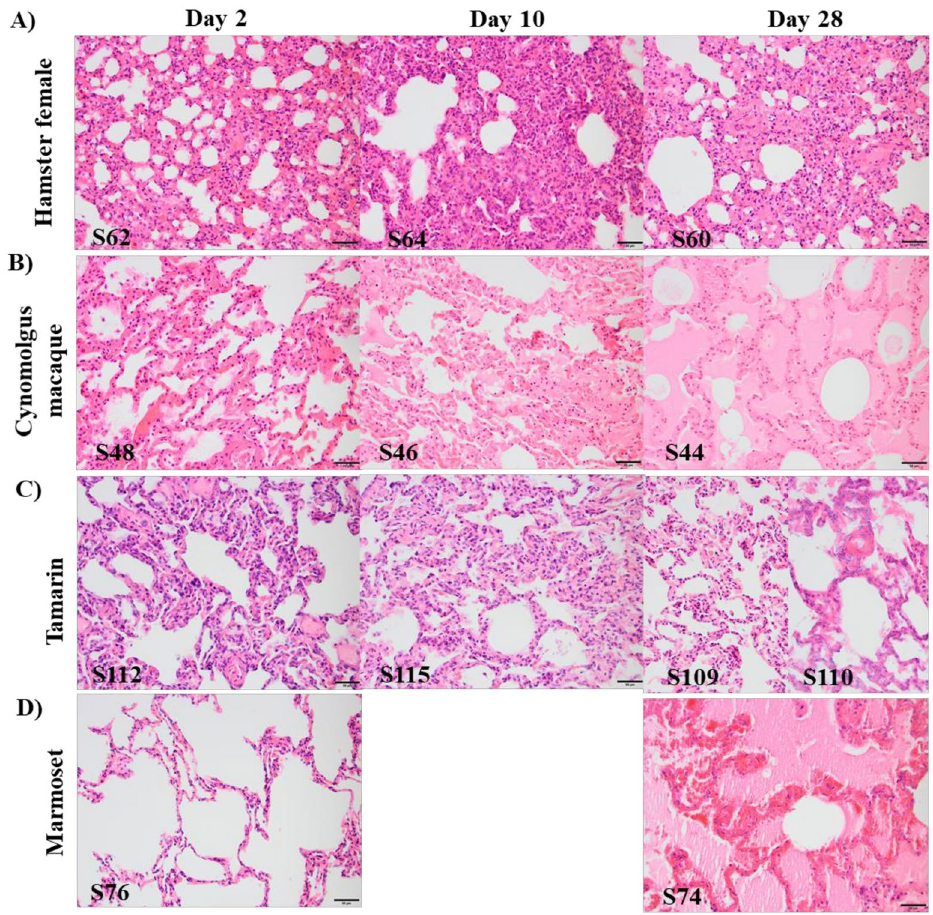
Figure 5. Comparative histopathological outcomes in lung section across the time-course of four species. Haematoxylin and eosin (H&E) staining of representative sections of lung tissue for: ( A ) female hamster lungs showing multifocally extensive alveolar wall congestion and mild to moderate protein-rich alveolar oedema. Foci of interstitial pneumonia with type II pneumocyte hyperplasia, and infiltrates of mixed inflammatory cells, including neutrophils, and single cell necrosis. ( B ) cynomolgus macaque; (S44, d28) diffuse, marked flooding of alveolar spaces with protein-rich oedema. ( C ) tamarin lung (e.g. S110, d28) typified by multifocal alveolar wall degeneration and necrosis with multifocal organising fibrin exudation. Alveolar wall necrosis, abundant fibrin exudation and hyaline membrane formation. ( D ) marmoset, showing multifocally extensive alveolar wall necrosis, intra-alveolar fibrin exudation and haemorrhage at day 28 (S74). Alveolar wall necrosis, abundant fibrin exudation and early hyaline membrane formation were present. Bar represents 50